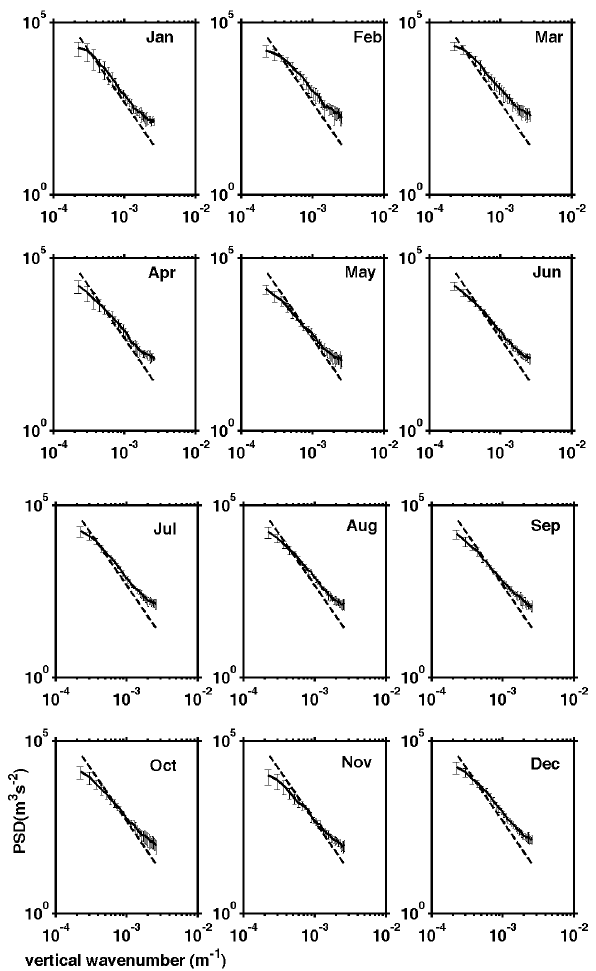
Fig. 6. Ten-year monthly mean vertical wavenumber spectra of total kinetic energy (solid line) along with the model predicted spectra (dashed line) for 12 months (January to December).